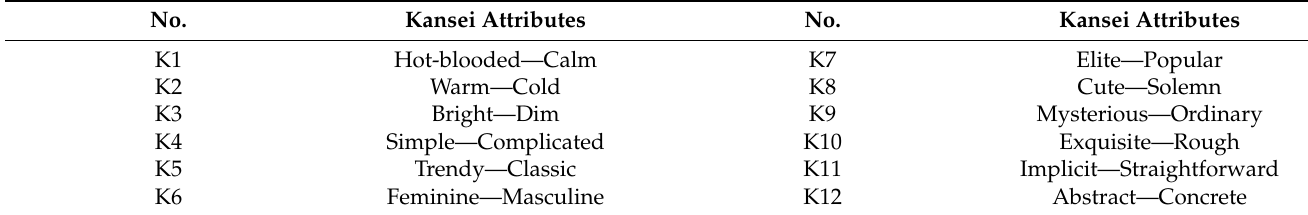
Table 2. Twelve Kansei